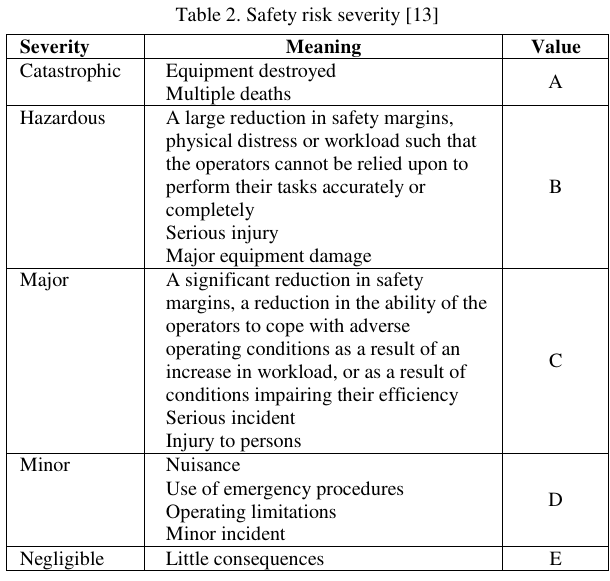
Table 2. Safety risk severity [13]